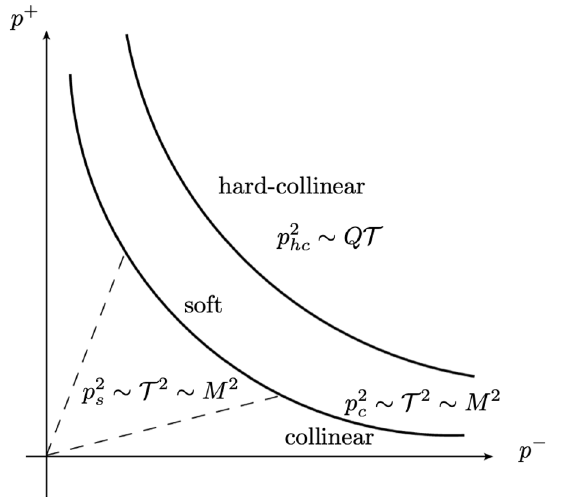
∼ p 2 ∼ M 2 ∼ T 2 . c s